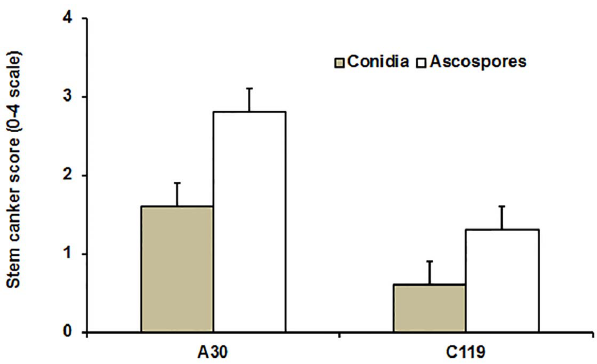
Figure 7. Severity of phoma stem canker symptoms. Leaf petioles of oilseed rape doubled haploid lines A30 (susceptible) or C119 (with quantitative resistance) were inoculated with conidia of isolate ME24/3.13 or ascospores of Leptosphaeria maculans ; severity of stem canker was assessed on a 0–4 scale at 46 days post inoculation (dpi) (ascospore inoculum) or 87 dpi (conidial inoculum). Bars show standard errors (17 d.f. for conidial inoculation; 50 d.f. for ascospore inoculation).